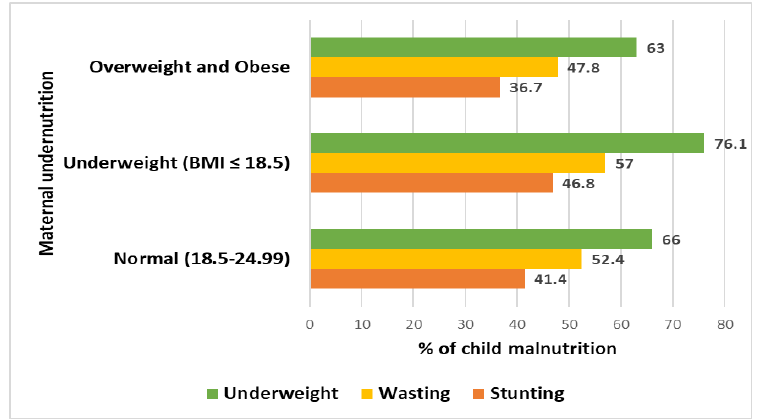
Figure 2. Distribution of child malnutrition based on maternal BMI . Table 2. General characteristics of the children by maternal BMI .